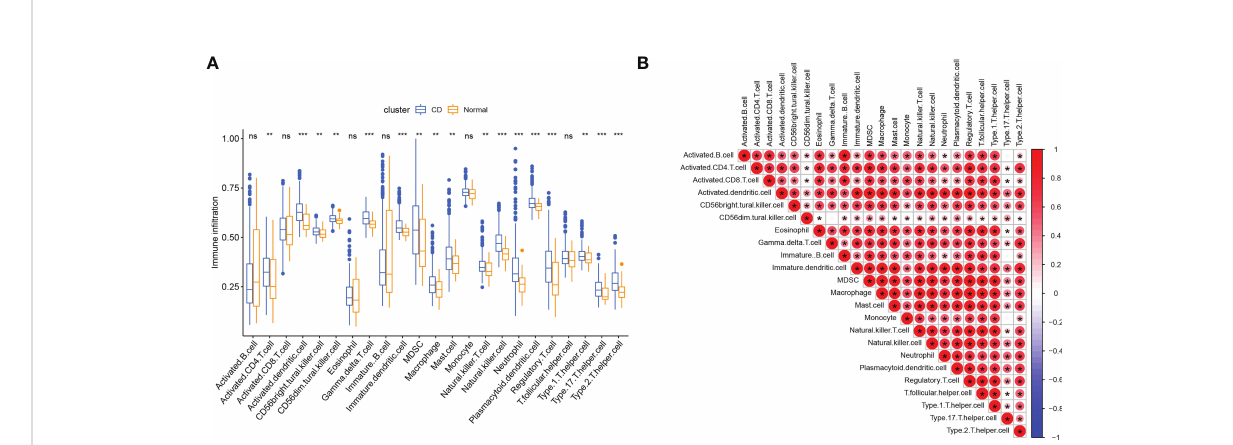
FIGURE 3 Immune cell in fi ltration in patients with CD. (A) Correlation matrix of all 23 types of immune cell subtype compositions. (B) Comparison of 23 immune cell subtypes between patients in CD and controls; The size and color of the circle represent the Pearson correlation coef fi cients. ns, no signi fi cance; * represents p < 0.05, ** represents p < 0.01; *** represents p < 0.001.